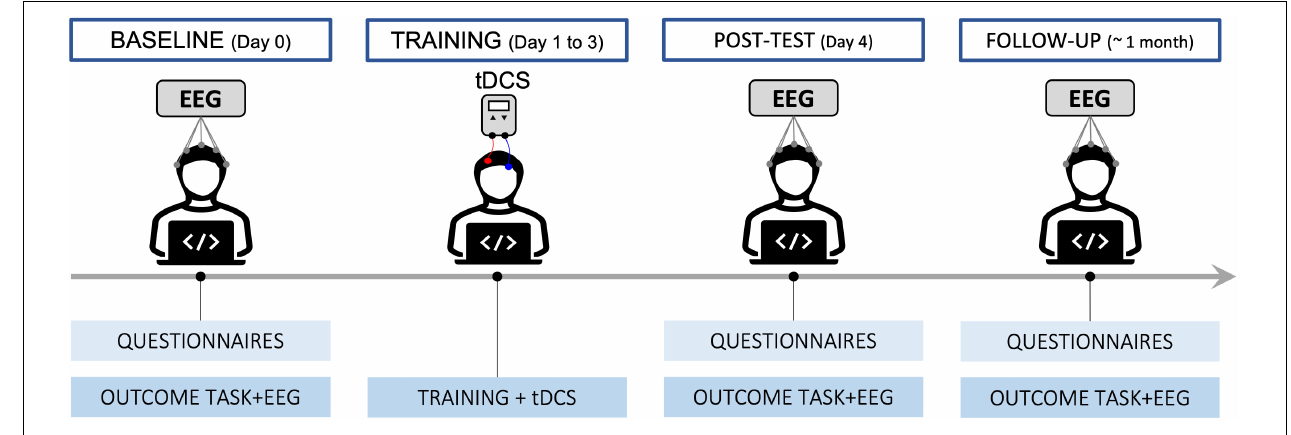
FIGURE 1 | Diagram describing the timeline of the